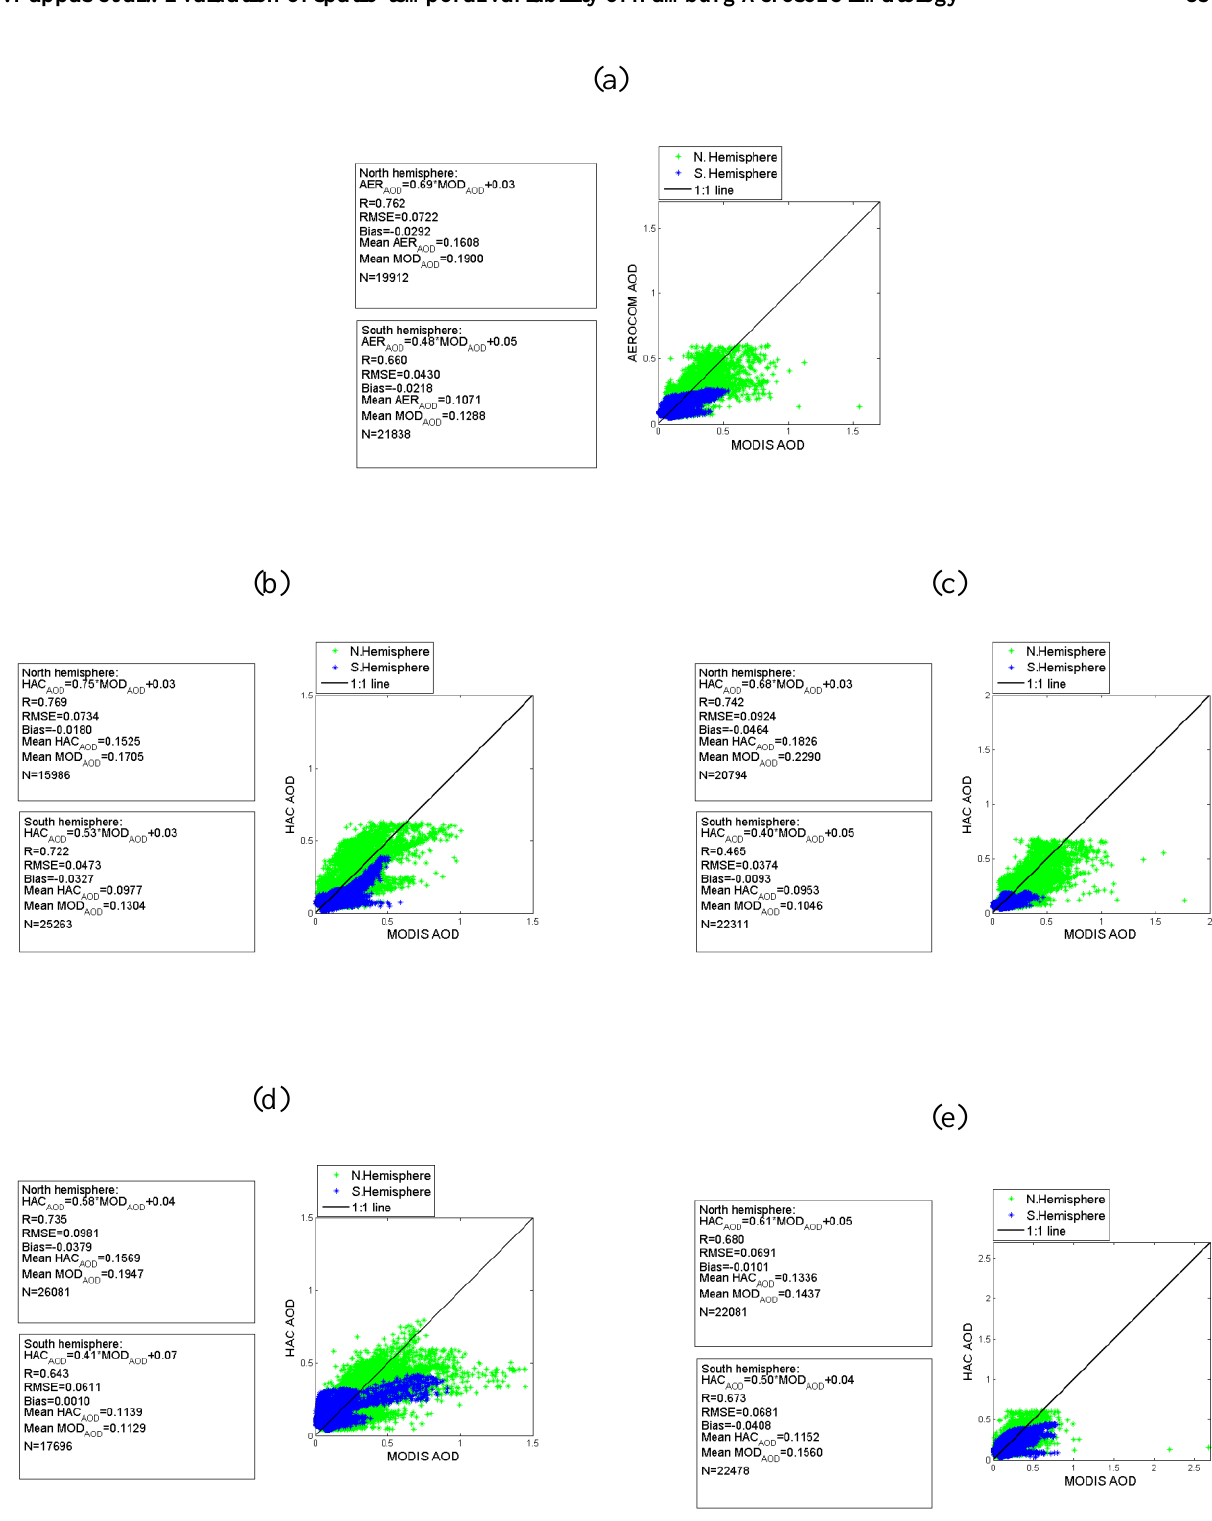
Fig. 4. Scatter plot comparison between total aerosol optical depth from HAC (AeroCom based) and MODIS datasets, for all months (a) , and for DJF (b) , MAM (c) , JJA (d) and SON (e) . Green points are for Northern Hemisphere and blue points for Southern Hemisphere. Black line in the plots is the 1 : 1 line. Statistics given in the text boxes in the plots separately for Northern Hemisphere and Southern Hemisphere are the correlation coefficients ( R ), the root mean squared errors (RMSEs), the mean values (Mean), and the number of matched data pairs ( N ).